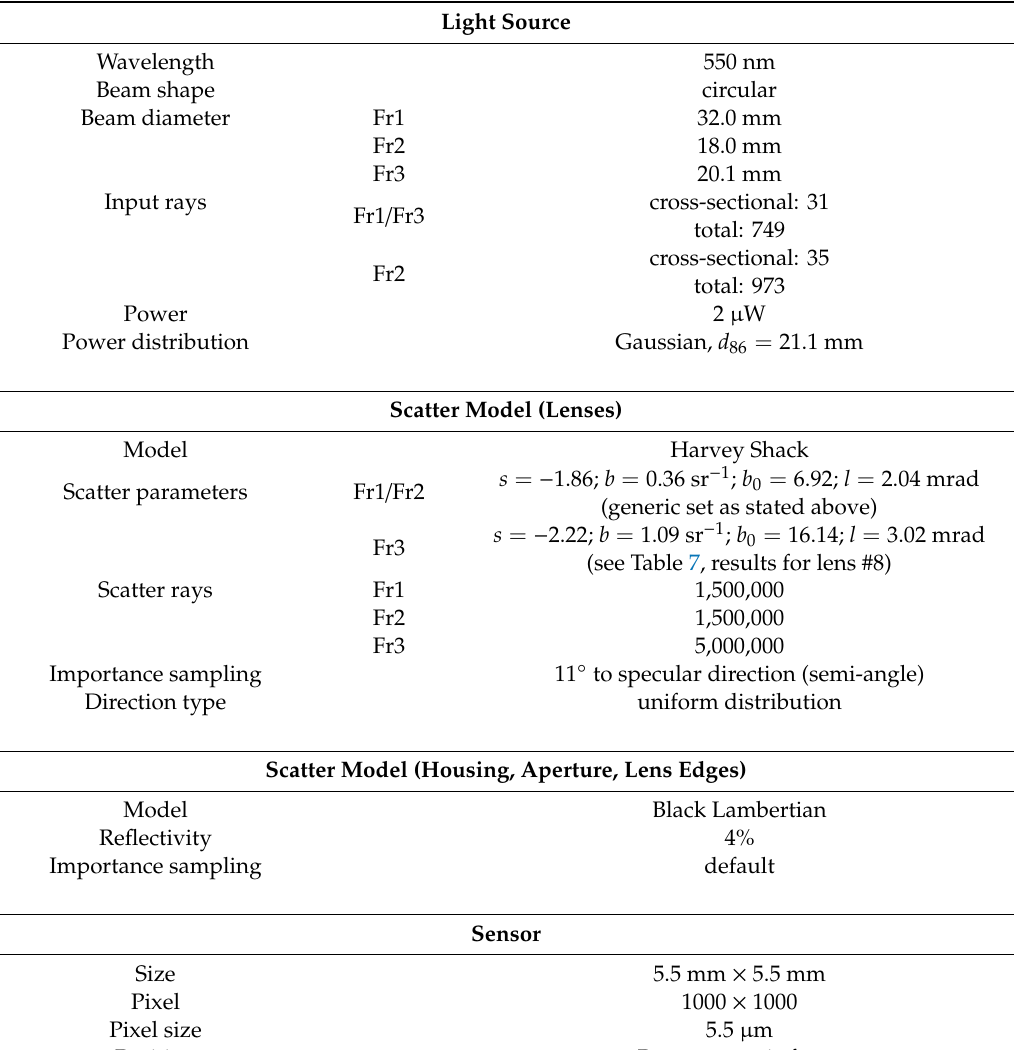
Table A9. Settings of the FRED software parameters for the stray light